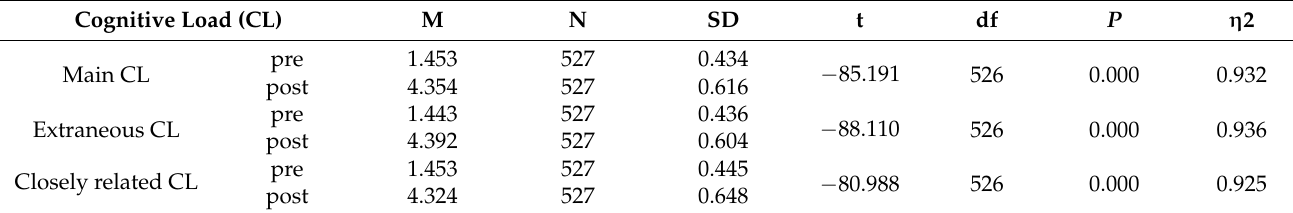
Table 4. The results of paired sample t -test in relation to cognitive